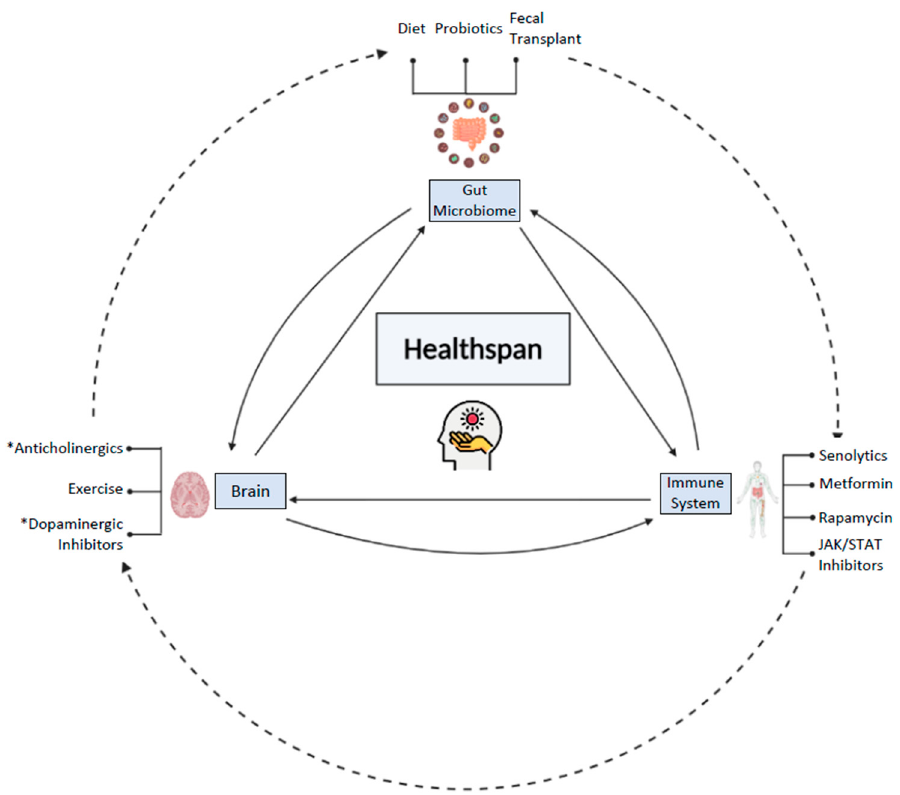
Figure 1. The gut microbiome, immune system, and brain all cross-communicate and can be mod- ulated by interventions to improve healthspan and lifespan. Some interventions (Section 4) may more directly impact one system, some may impact indirectly, such as the direct impact of diet (Section 4.2) and fecal transplant (Section 4.5), and the indirect impact of exercise (Section 4.8) on the gut microbiome. Nonetheless, the gut microbiome (Sections 4.2–4.5), the brain (Sections 2 and 4.8), and the immune system (Sections 4.6 and 4.7) are all connected to one another, and along with age, change in one system can subsequently impact the other systems, ultimately impacting healthspan and lifespan as well. Moreover, the impact of individuals and combinations of inter- ventions on the key players of healthspan and lifespan are still being explored (Section 5). (*) indicates that a drug more specifically improves healthspan for Alzheimer’s/Parkinson’s patients, whereas the other interventions are meant for a broader population. This figure was created with Biorender.com.